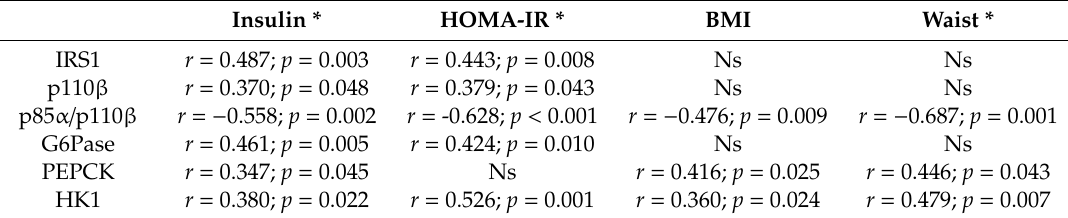
Table 2. Significant correlations found between mRNA expression levels with anthropometric and biochemical variables.